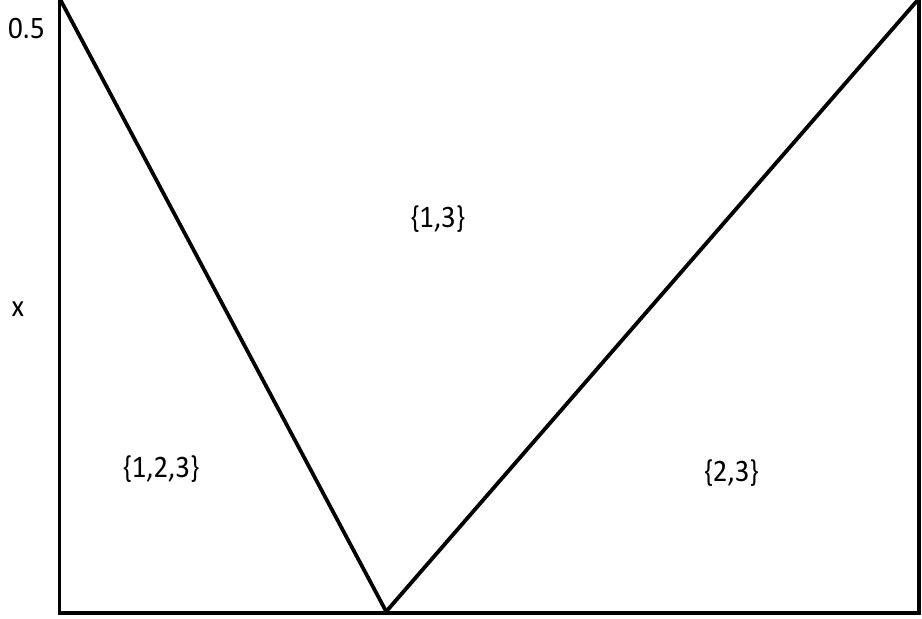
Figure 3. Coalitions with 3 as